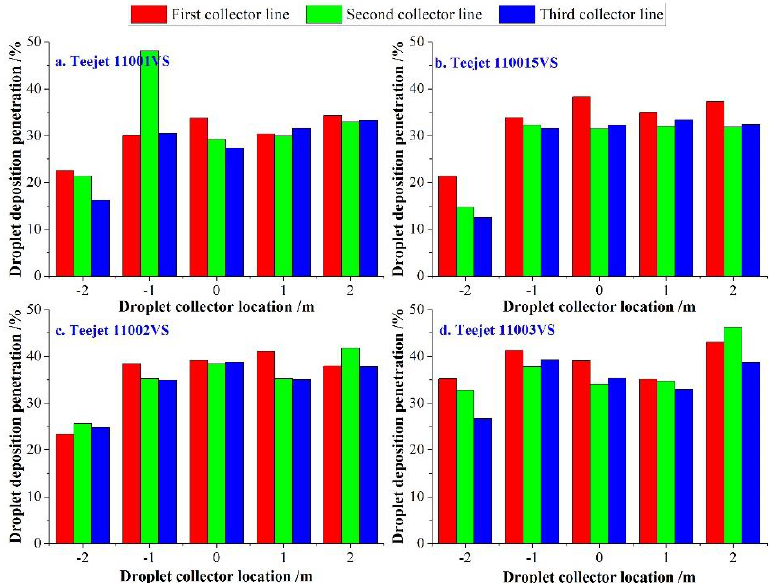
Agronomy 2020 , 10 , 195 Figure 7. Droplet deposition penetration in target area. Figure 7. Droplet deposition penetration in target area.